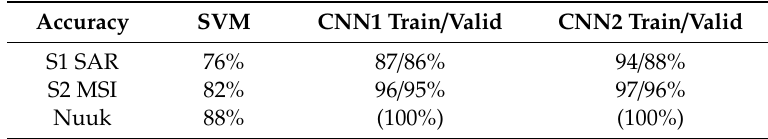
Figure 8. Scatter plot of MSI ships (blue) and icebergs (yellow) classified according to ( a ) breadth to length ratio vs. area; ( b ) redness vs. average object reflection.